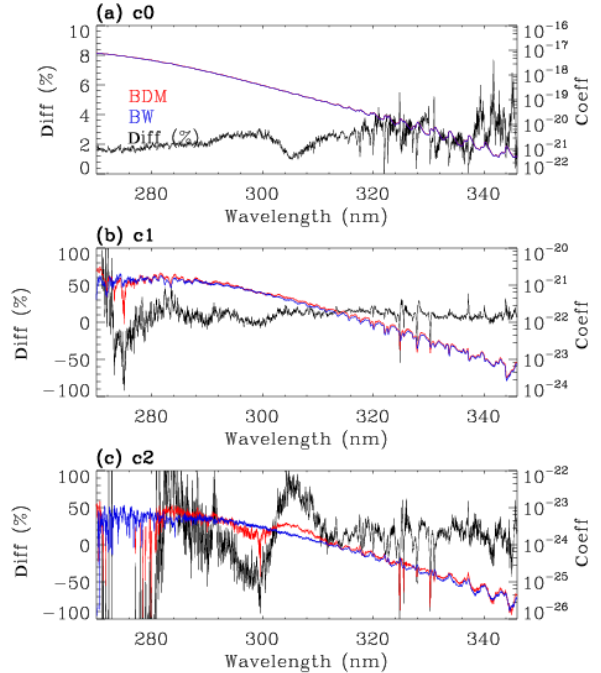
Figure 2. Quadratic coefficients (cm 2 molecule − 1 ) to parameterize the temperature dependence of ozone cross-sections for BDM (red) and BW (blue), respectively, with their relative differences (BDM– BW)/BW in